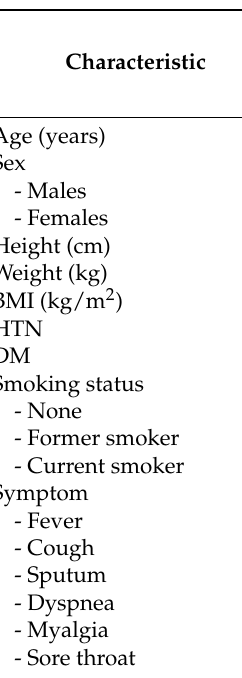
Table 1. Clinical characteristics of COVID-19 and pneumonia patient